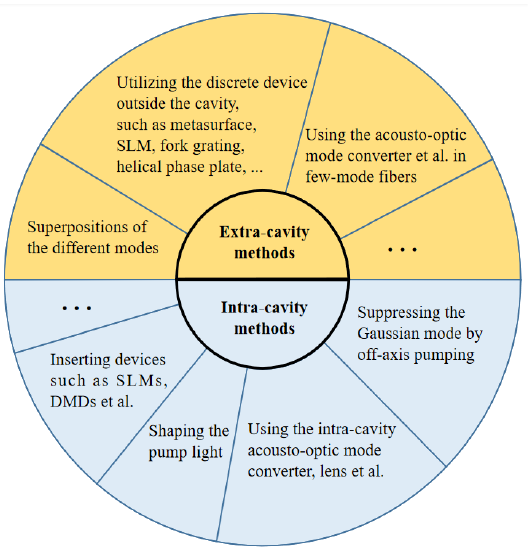
Figure 1. The generation of the structured light with intra- and extra-cavity methods.